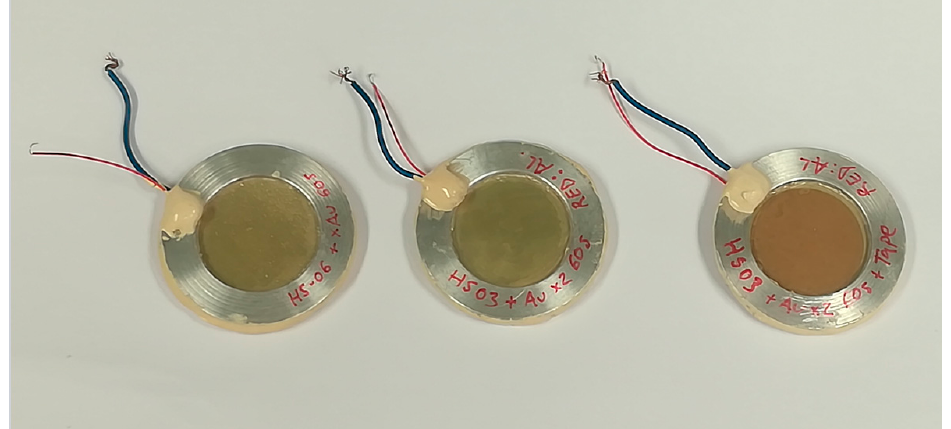
Figure 2. Picture of the prepared FE films for measurements. The HS03 sample with the adhesive tape is shown on the right; the brawn adhesive tape can be seen on top of the Au layer. The experimental set-up is shown in Figure 3. A couple of identical ultrasonic trans- ducers are positioned in opposition and aligned and the sample to be measured is located in between them at normal incidence. in Figure 4.